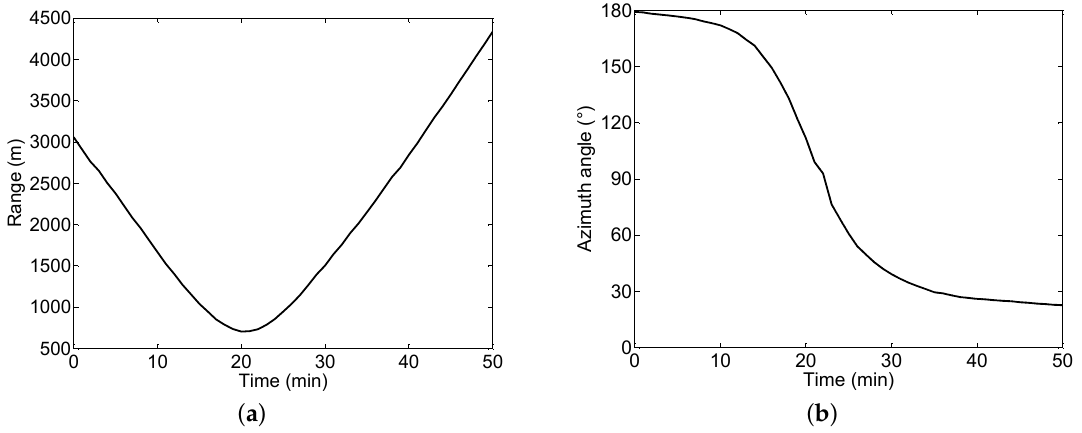
Figure 14. The ranges ( a ) and azimuth angles ( b ) between source and array from J131 23:40 GMT to J132 00:30